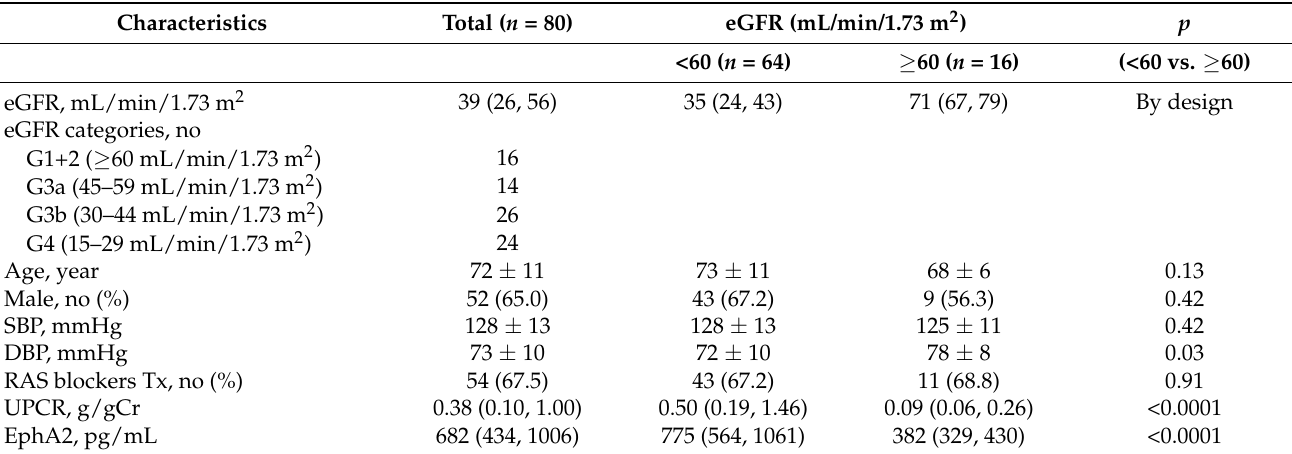
Table 1. Clinical characteristics and serum EphA2 levels in patients with hypertension.